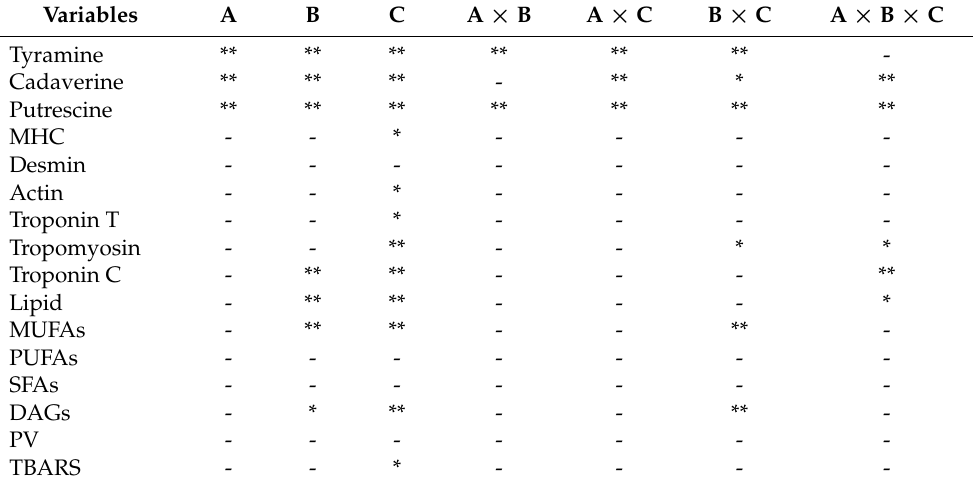
Table 4. Influence of factors on biogenic amines, proteolysis, and lipid fraction using three-way ANOVA. A: Sausage size. B: Starter cultures. C: Ripening time (sampling point).